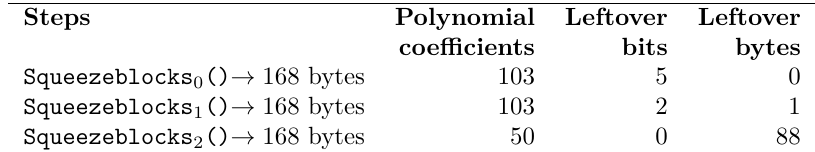
Table 1: Leftover bits and bytes during the construction of the first polynomial of AAA Steps